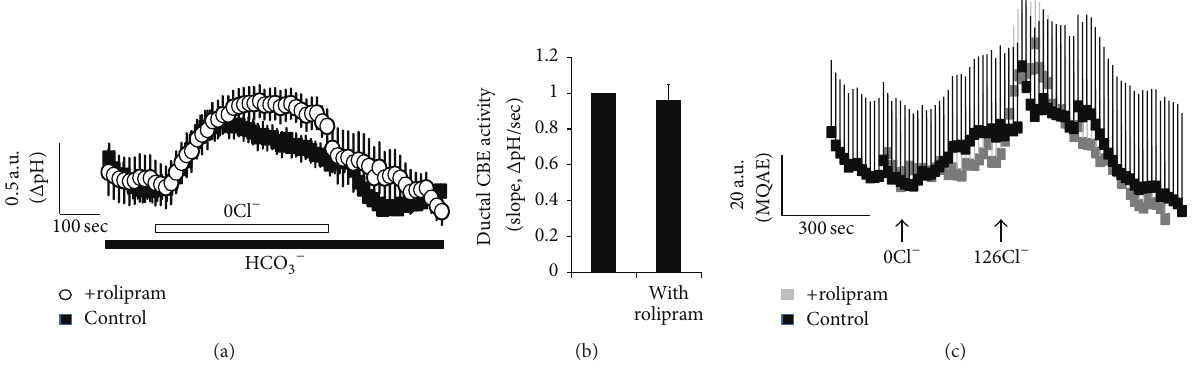
Figure 5: Effect of rolipram on chloride/bicarbonate exchanger activity. (a) Changes in intracellular pH (pH i ) in the ductal cells in the presence of rolipram (open circle) and control (closed black square). (b) Ductal chloride/bicarbonate exchanger (CBE) activity. The slope of pH i assessed CBE activity in the absence of Cl − at the beginning of time course (30 ∼ 45 sec) and height to reach maximum pH i point from minimum point. The bars show the mean ± SEM ( 𝑛 = 3 ). (c) Changes of intracellular Cl − concentration. Ductal cells were loaded with MQAE dye and fluorescence was monitored in the presence of rolipram (closed gray square) and control (closed black square). The traces were measured with arbitrary MQAE intensity every 3